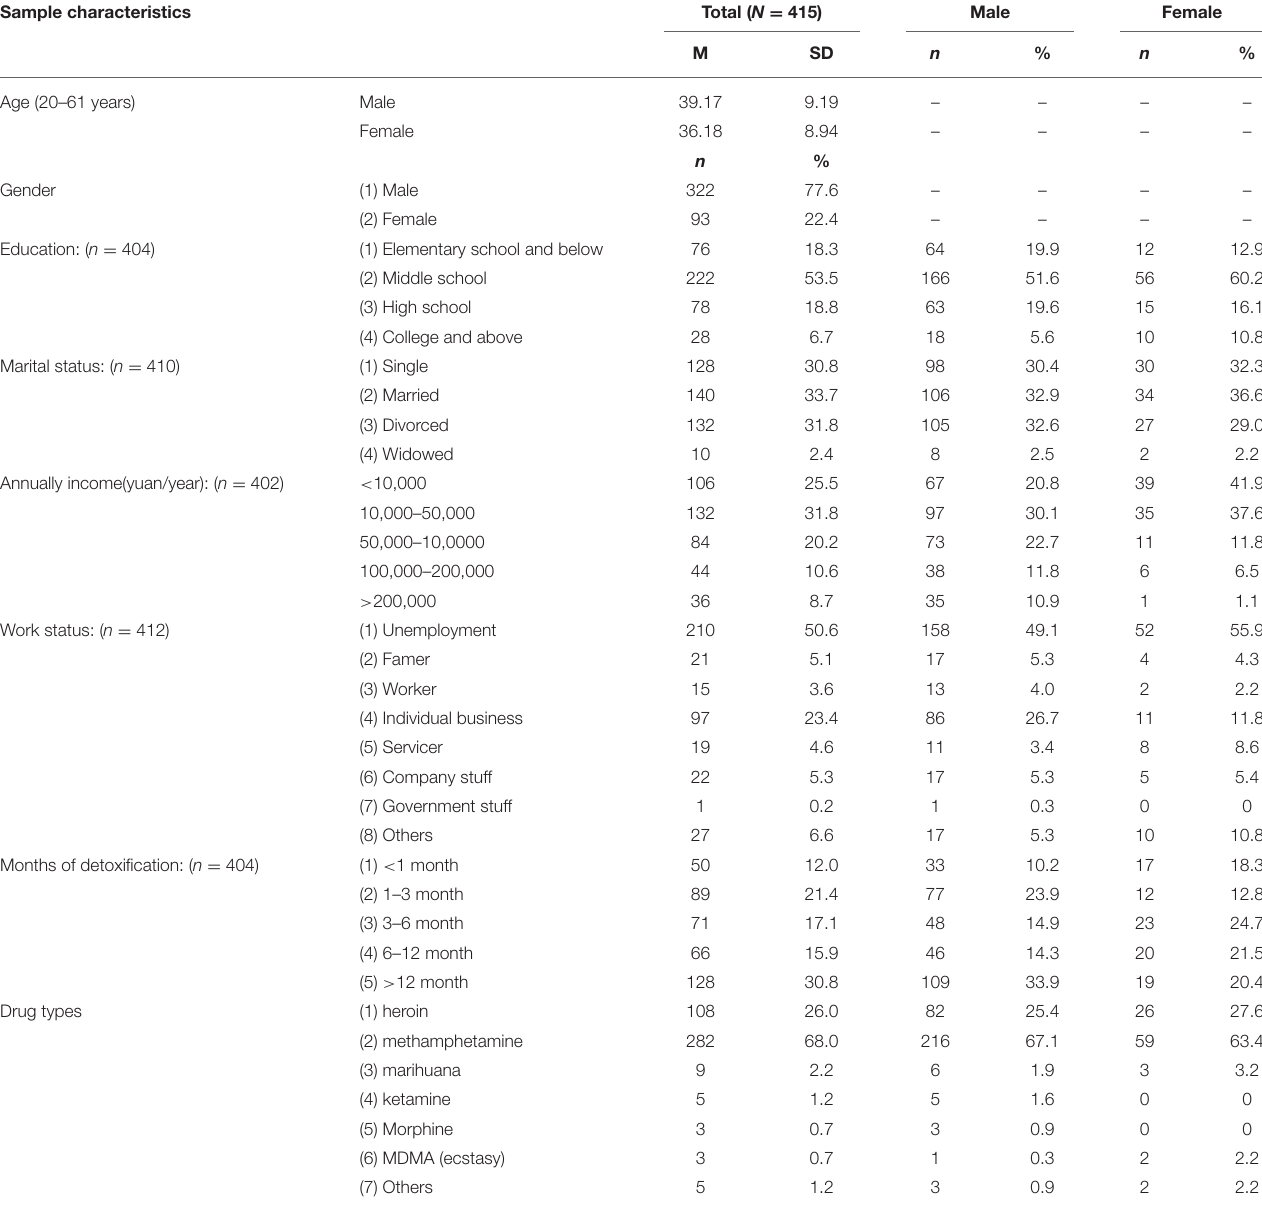
TABLE 1 | Sample characteristics. Sample